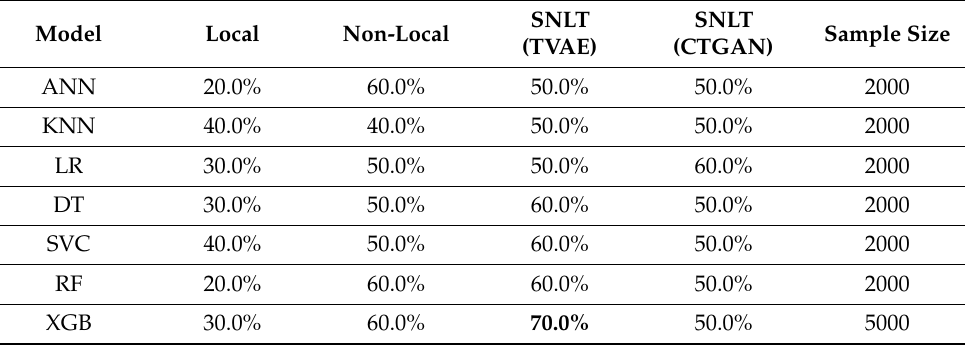
Table 7. Train SD, test Highmore, SD only one variety per year resulting in 10 target samples: best accuracies (bold) from Highmore local training, non-local training (rest of SD), and SNLT with CTGAN and TVAE (rest of SD), each for three class labels (high, medium, and low yield), plus size of synthesized